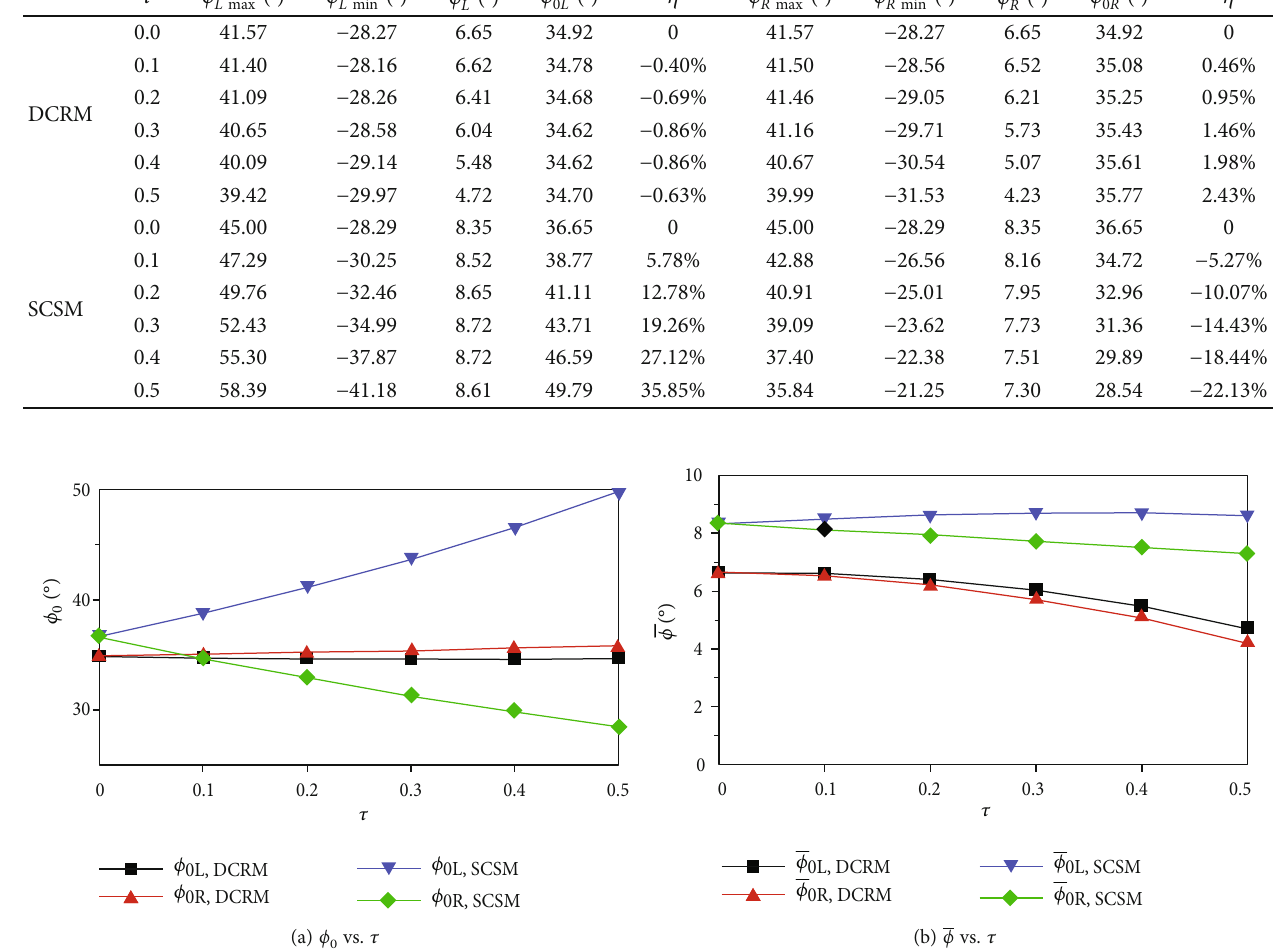
Figure 7: Comparison of ϕ